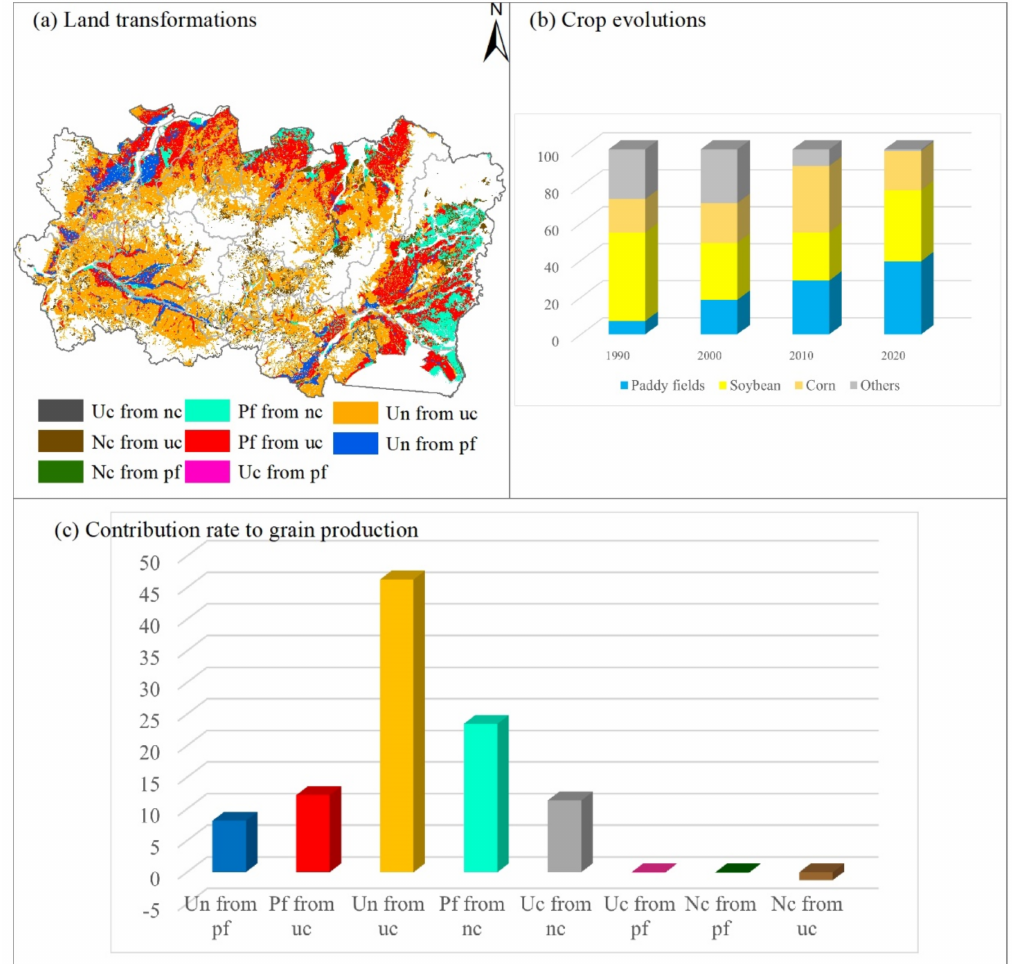
Figure 5. Landscape pattern statistics of cropland structure change at landscape and type scales during the period of 1990–2020. Abbreviation: Uc from nc: upland crops converted from noncropland, Nc from uc: noncropland converted from upland crops, Nc from pf: noncropland converted from paddy fields, Pf from nc: paddy fields converted from noncropland, Pf from uc: paddy fields converted from upland crops, Uc from pf: upland crops converted from paddy fields, Un from uc: unchanged upland crops, and Un from pf: unchanged paddy